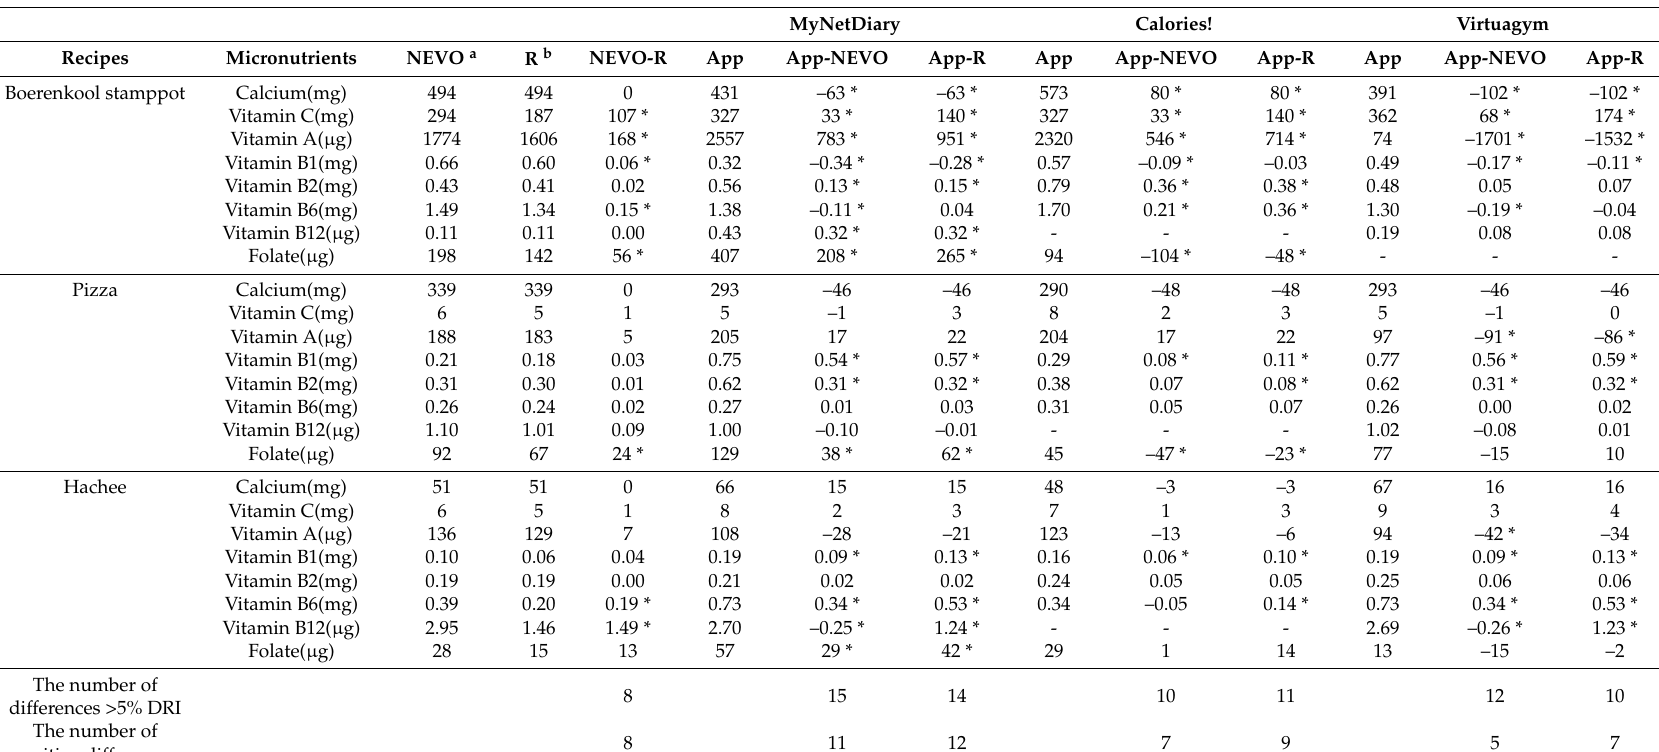
Table 5. Comparison of micronutrient contents between recipes added by raw ingredients from three apps with recipes added by raw ingredients from the Dutch food composition database (NEVO), with NEVO multiplied by retention